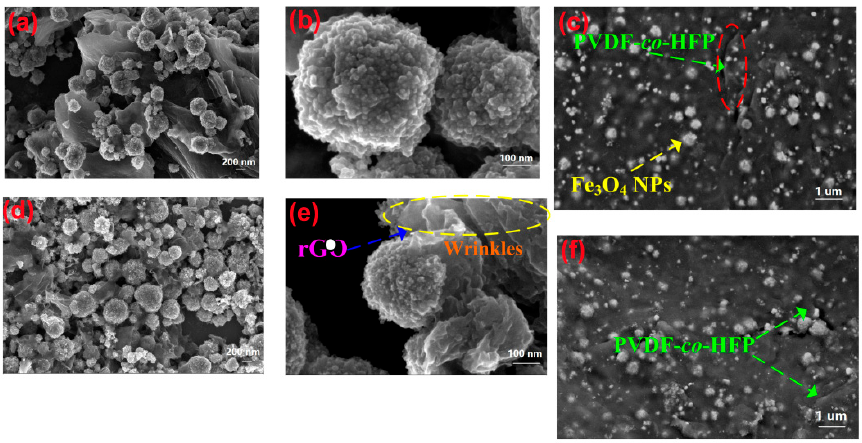
Figure 1. SEM images of ( a , b ) Si(1)-rGO@Fe 3 O 4 , ( c ) the film of S1 sample, ( d , e ) Si(2)-rGO@Fe 3 O 4 , ( f ) the film of S2 sample.